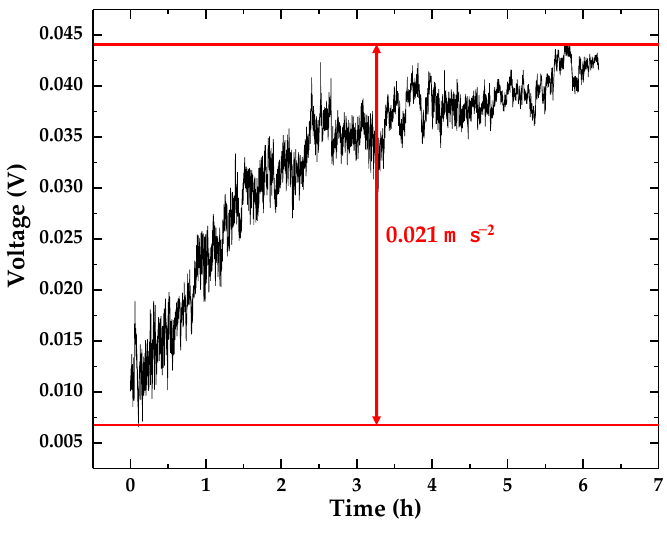
Figure 14. The drift of the optical accelerometer.